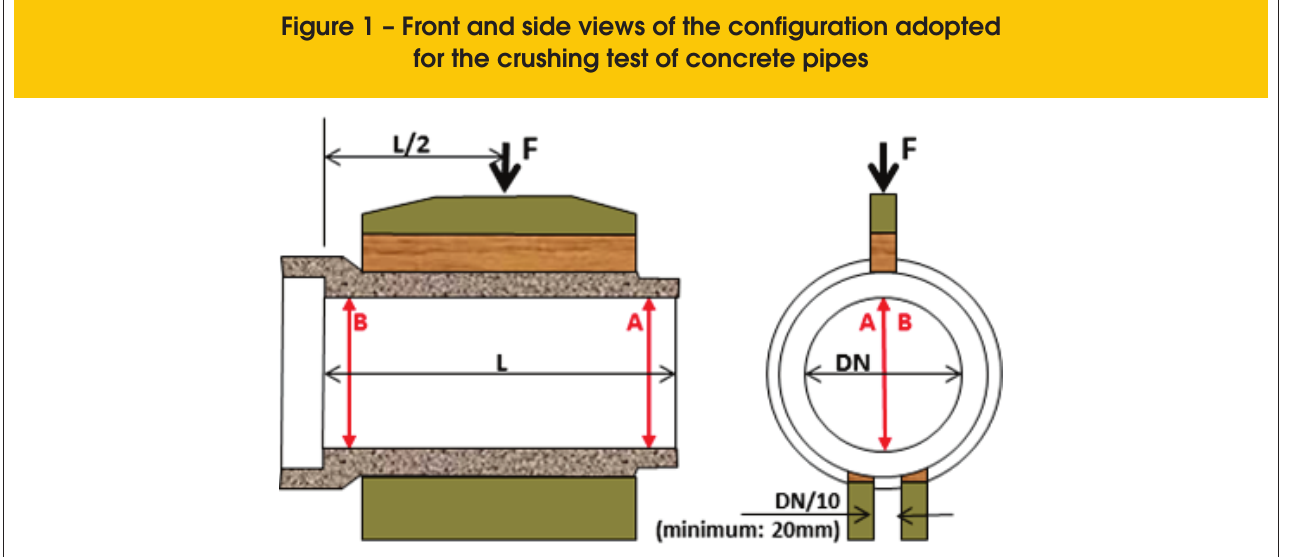
Figure 1 – Front and side views of the configuration adopted for the crushing test of concrete